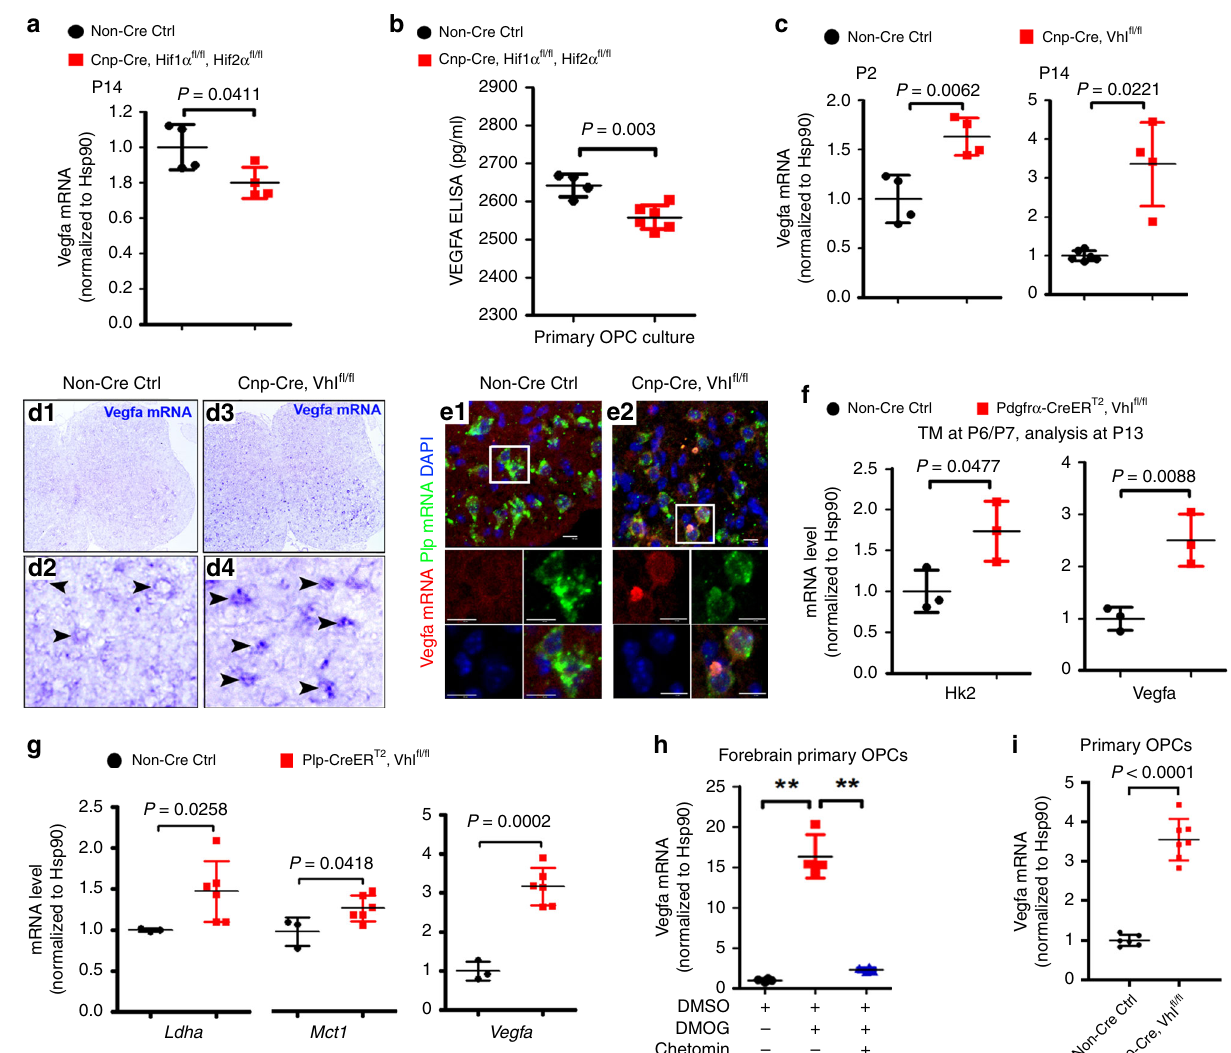
Fig. 6 Oligodendroglial HIF α regulates VEGFA expression. a RT-qPCR assay of Vegfa mRNA in the spinal cord of P14 mice. Two-tailed Student ’ s t test, t (6) = 2.590. n = 4 Ctrl, 4 HIF α cKO. b ELISA measurement of VEGFA concentration in the culture medium of primary OPCs isolated from neonatal